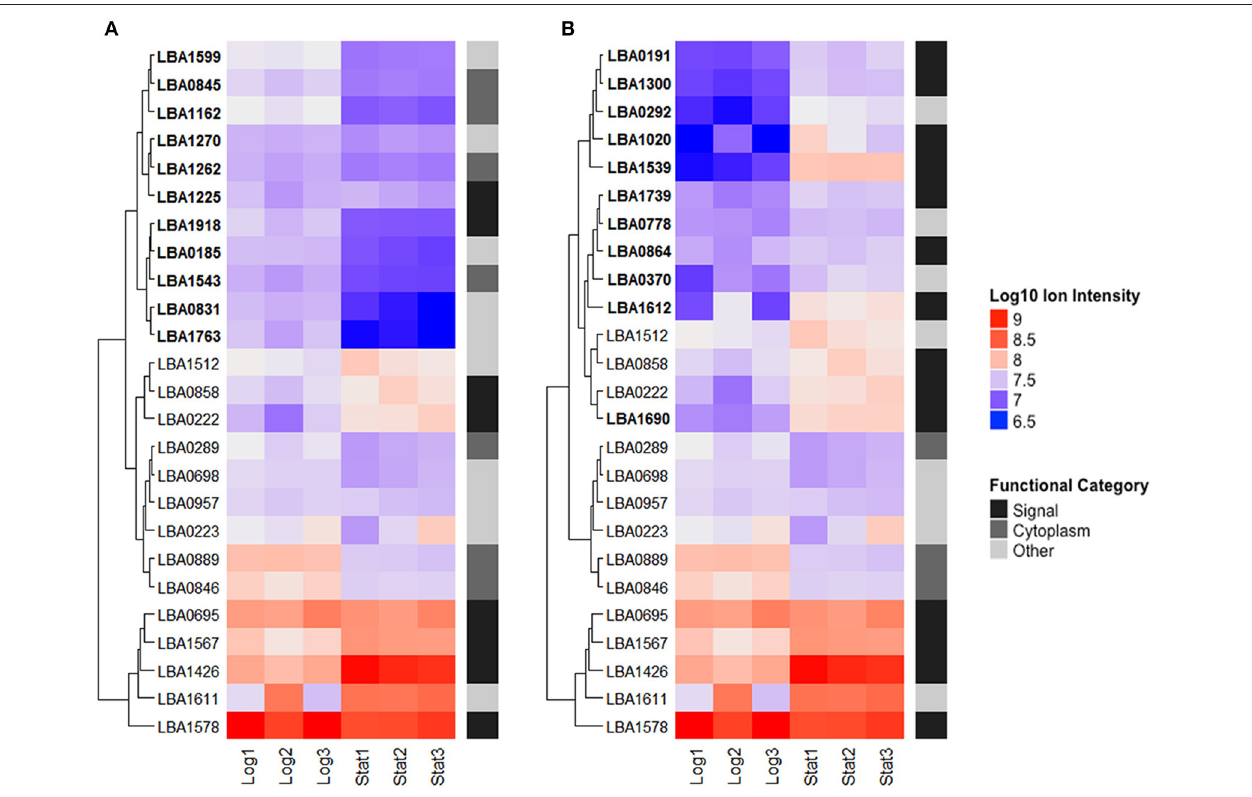
FIGURE 5 | The top 25 most abundant S-layer associated proteins in logarithmic (A) and early stationary (B) growth phases . Proteins are clustered based on their Log10 ion intensities for both growth phases. Functional categories are labeled on the right. Unique proteins are bolded. Additional information about these proteins can be found in Table 1